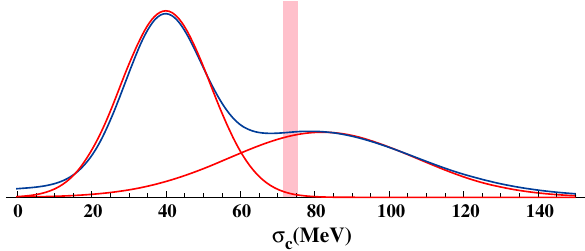
Fig. 9 Ideogram compiling lattice and phenomenological calculations of σ c andourrepresentationasasumoftwoGaussians(30).Alsoshown is a vertical pink band from our evaluation of the O (α 3 s ) perturbative QCD calculation of [92], shown in